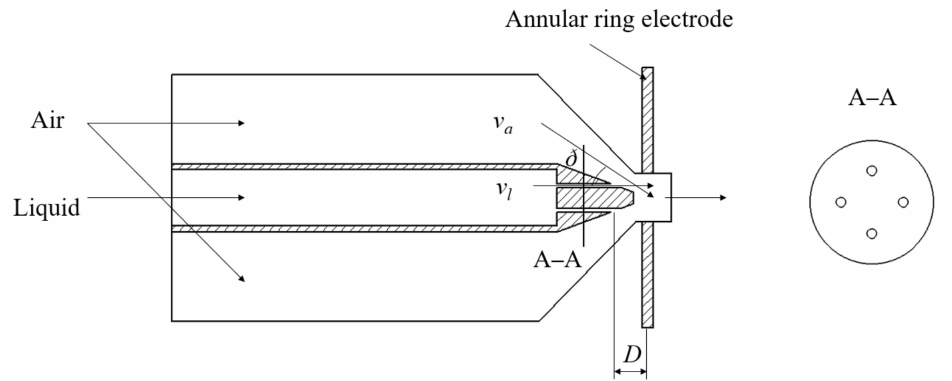
Figure 1. Schematic diagram of the air-induced, air-assisted electrostatic nozzle. v l and v a are the liquid velocity and air velocity, ð is the angle between the airflow and liquid when they meet in the nozzle tip, D indicates the distance between the liquid channel outlet and the annular ring electrode, A–A depicts the nozzle tip’s cross-section.